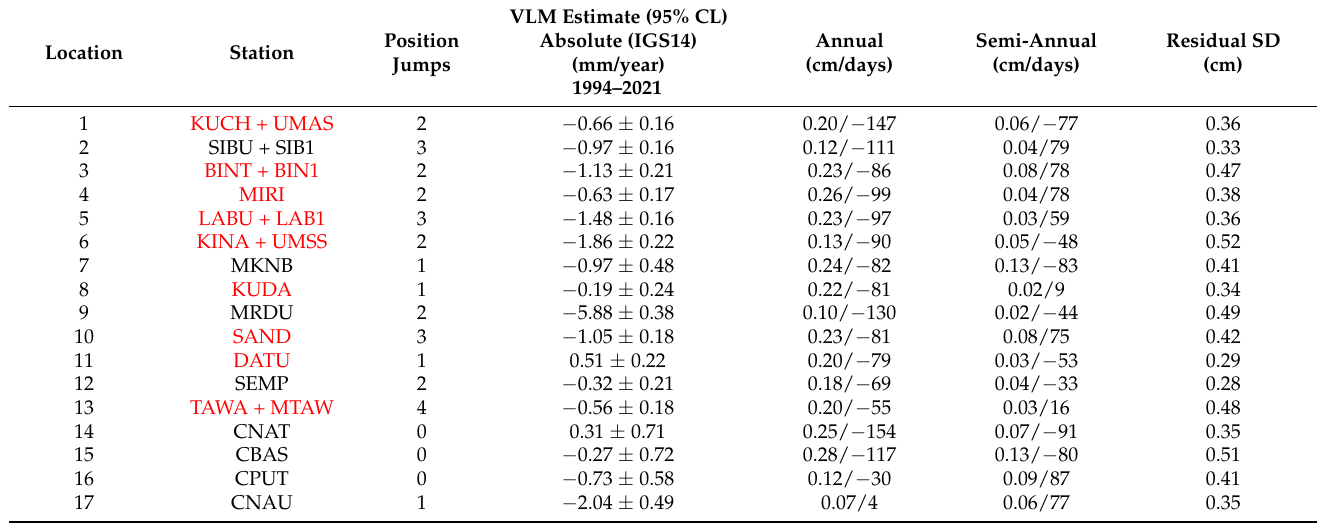
Table 7. VLM trend estimates at 17 locations in East Malaysia and Northern Kalimantan (1994–2021). The red font indicates that the station is located nearby a Malaysian tide gauge and combined MASS/MyRTKNet stations are given as MASS + MRTK. The linear trend estimates are given at a 95% confidence level (1.96 sigma). The number of estimated (vertical) position jumps for each station is given, and also the amplitude and phase of the annual and semi-annual signals. The residual sigma is the SD of the difference between the data and the model